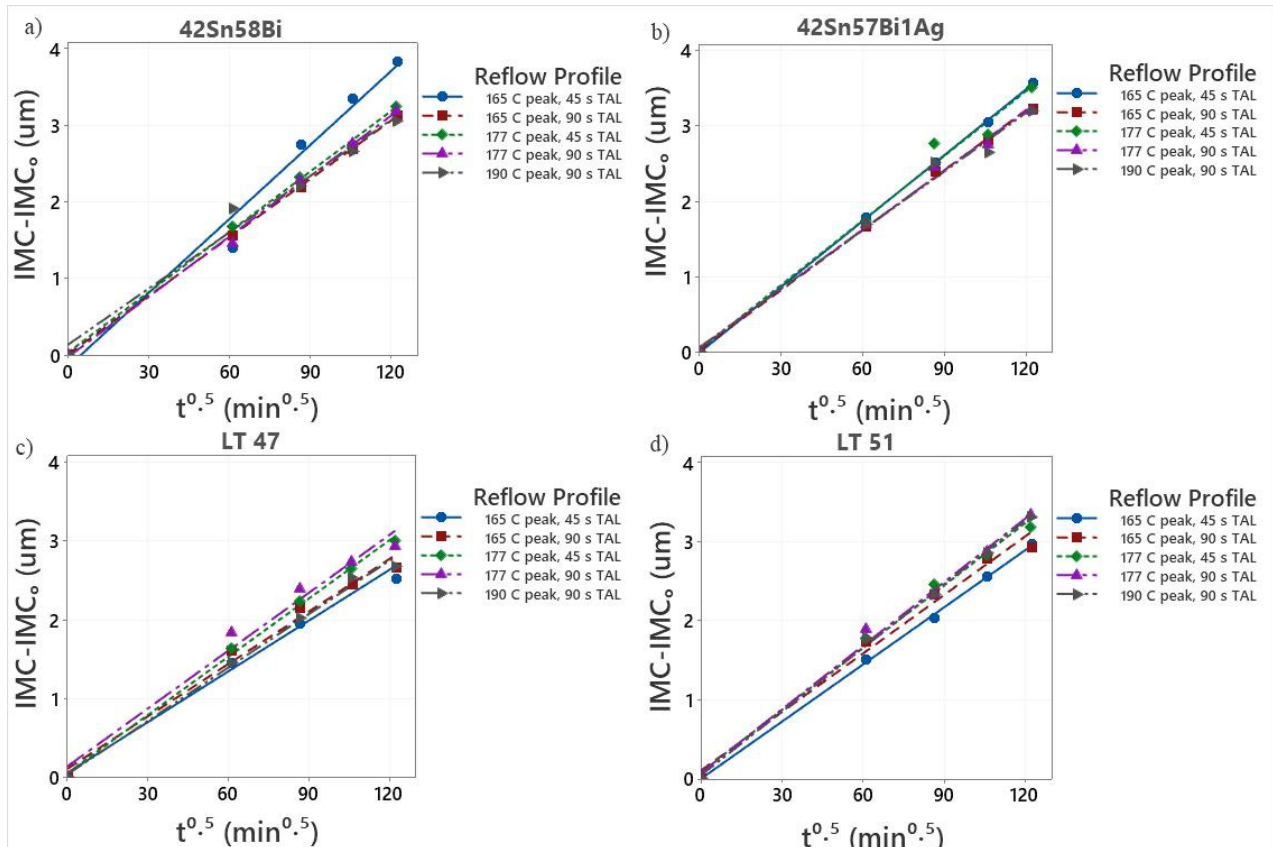
Figure 19. Graph plotting IMC evolution versus square root of time for ( a ) 42Sn58Bi, ( b ) 42Sn57Bi1Ag, ( c ) LT 47 and ( d ) LT 51. Table 5. Value of growth constant, k at 125 °C for tin–bismuth alloys.